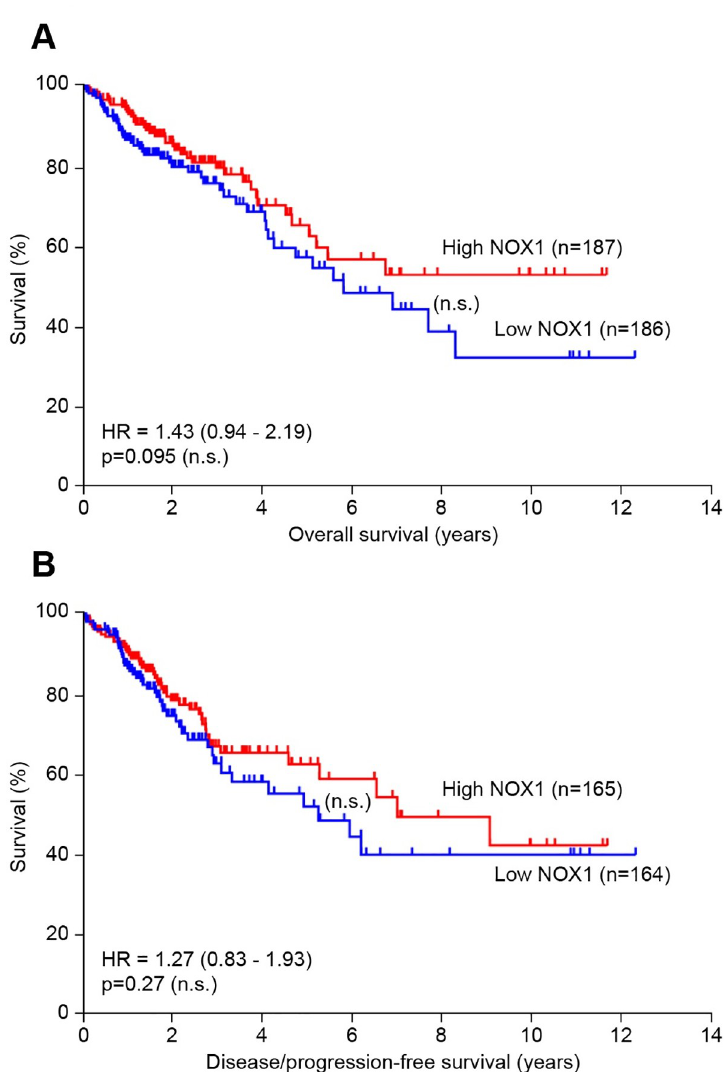
Fig 6. NOX1 expression and patient survival. In the TCGA colorectal adenocarcinoma dataset, 373 patients had known NOX1 mRNA and overall survival information; 329 patients had known NOX1 mRNA and disease/ progression-free survival. Kaplan-Meier curves displaying (A) overall survival and (B) disease/progression-free survival of these patients stratified into high and low NOX1 mRNA expressers. (A, B) The median NOX1 expression value was used as a cutoff, and no significant differences in overall survival or progression free survival were detected between high and low NOX1 expressers. et al . provided evidence directly implicating the flavoprotein NOX1 as the source of oncogenic RAS-dependent ROS [46]. The authors suggested that oncogenic RAS upregulated the expres- sion of NOX1 in normal rat kidney (NRK) epithelial cells and in NIH 3T3 mouse fibroblasts via the mitogen-activated protein kinase (MAPK) pathway, and that cellular transformation could be prevented by the knockout of NOX1 with a specific siRNA. In their studies, the flavo- protein inhibitor diphenylene iodonium (DPI) and the sulfhydryl donor N -acetylcysteine (NAC) readily suppressed mitogenic signaling, establishing a relationship between NOX1-der- ived ROS and malignant transformation by oncogenic RAS [46, 66].